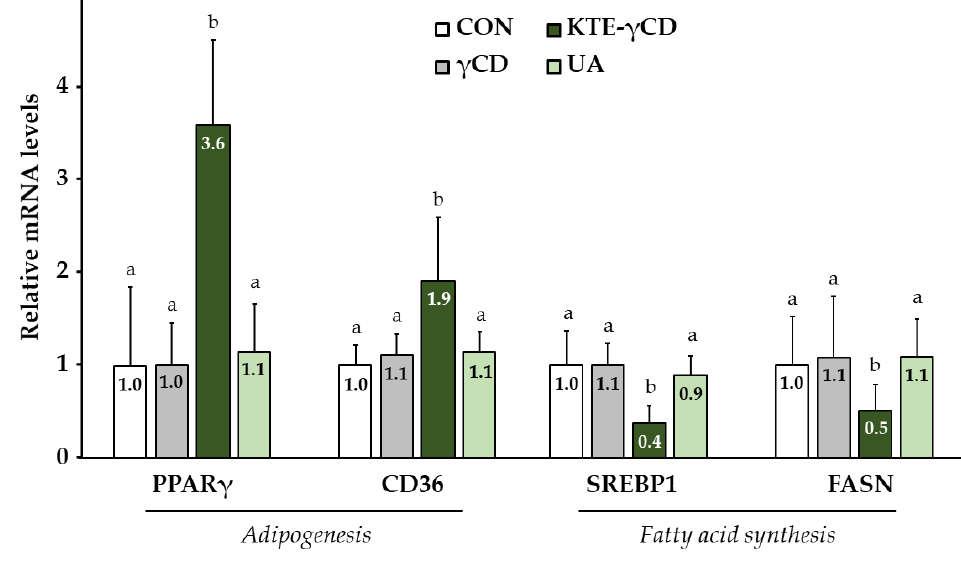
Figure 4. Kuding tea extract-γ-cyclodextrin (KTE-γCD) increased the mRNA levels of genes involved